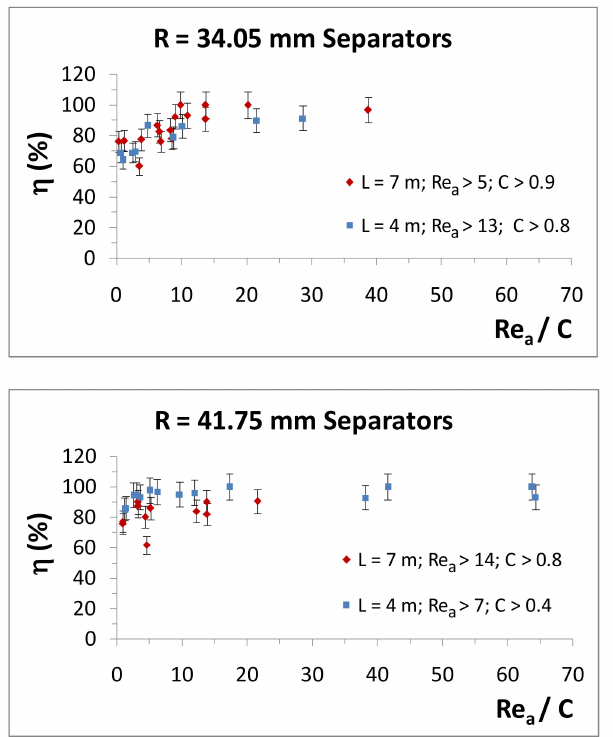
Figure 13. Relationship between ratio Re a /C and η (%) for the separators tested with different helix radiuses R (34.05 mm and 41.75 mm) and tube lengths L (4 and 7